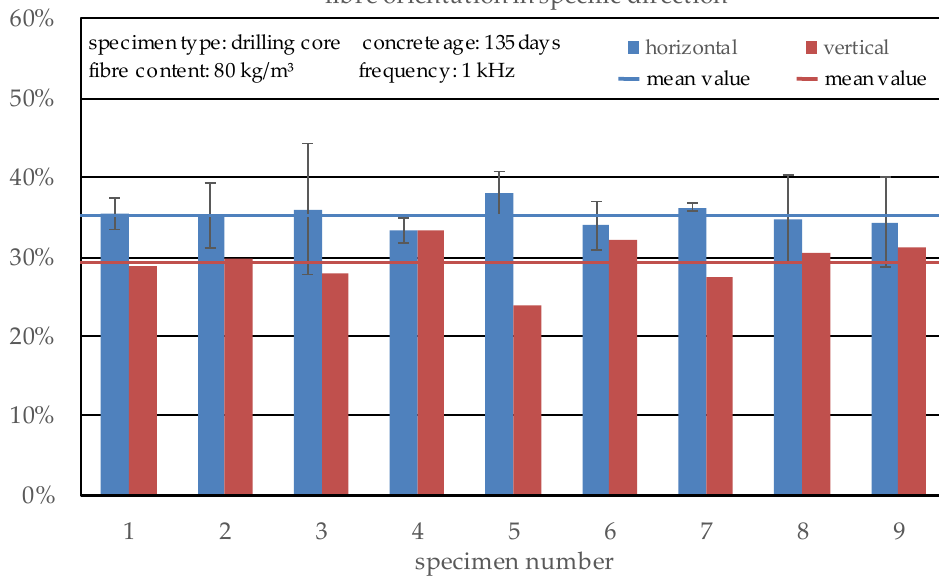
Figure 17. Calculated fibre orientation of the drilling cores with a fibre content of 80 kg/m³.